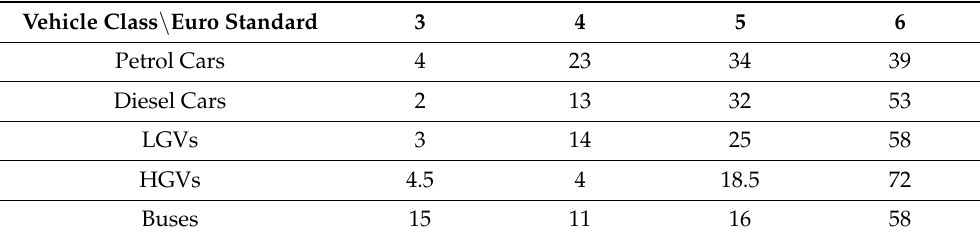
Table 3. The distribution (%) of EURO standard within the different vehicle types for